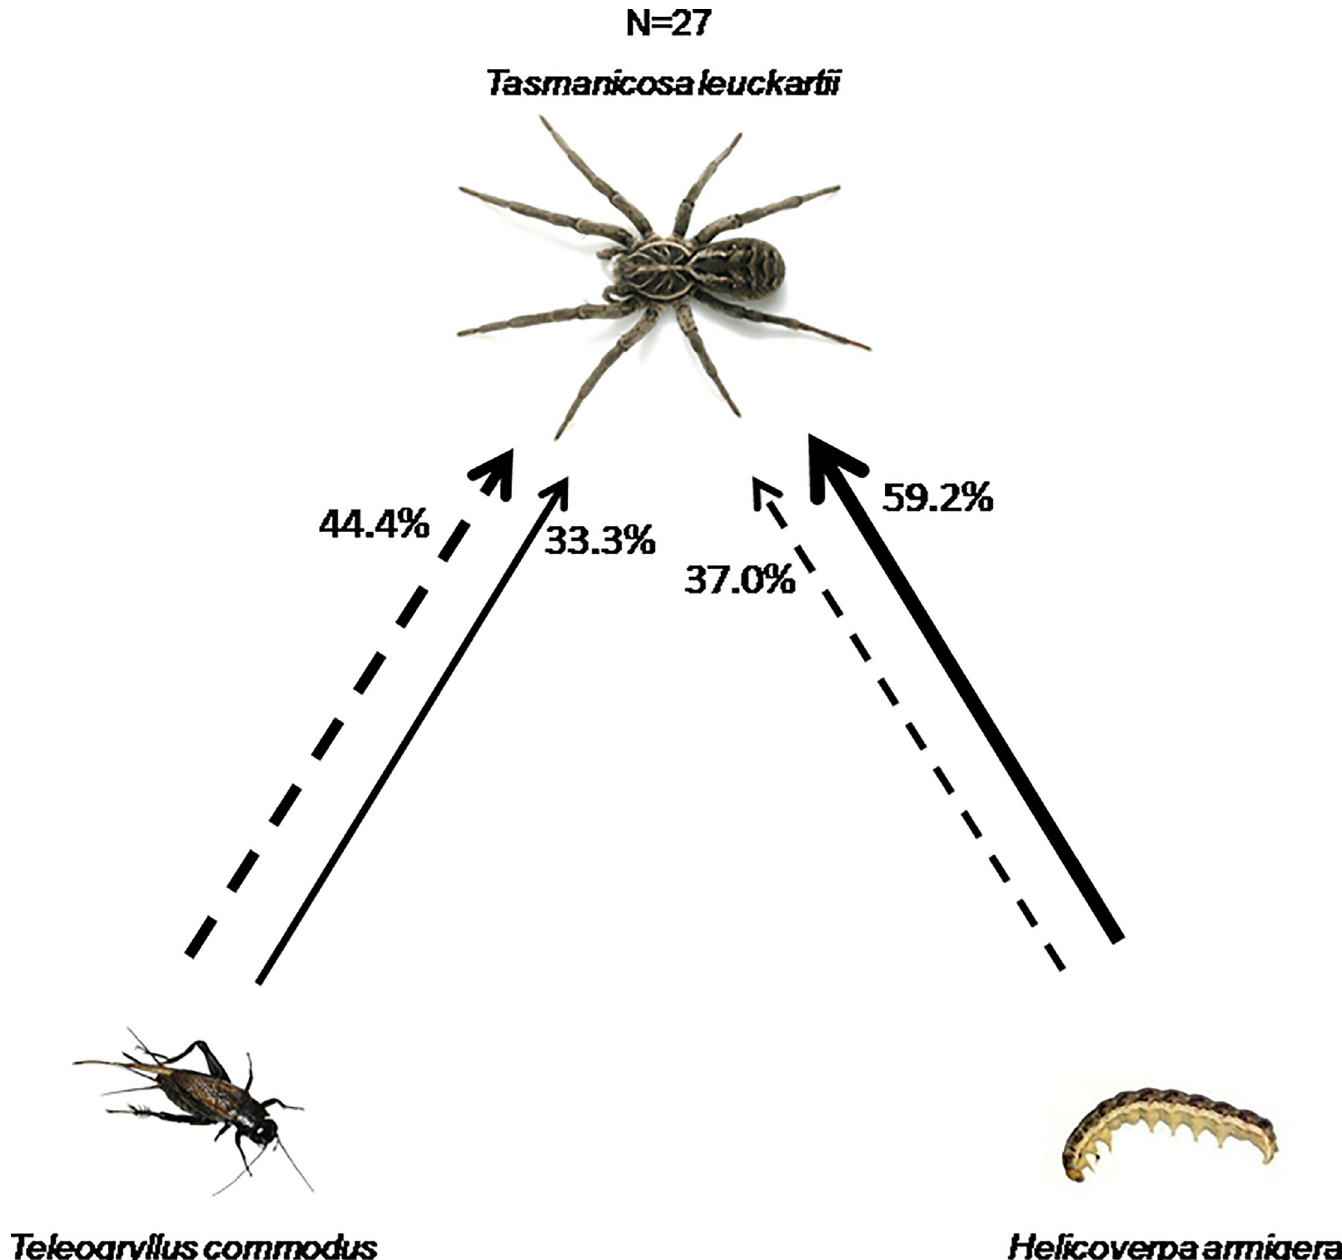
Fig 1. Percentages of first encounter (dashed arrows) and first attack (solid arrows) of Tasmanicosa in a three-way videorecorded food web arena. Direction of arrows point to the predator that made the encounter/attack, thicker arrows represent higher proportions. Percentages indicate cases in which prey was encountered first (out of n = 27), or attacked first (out of n =